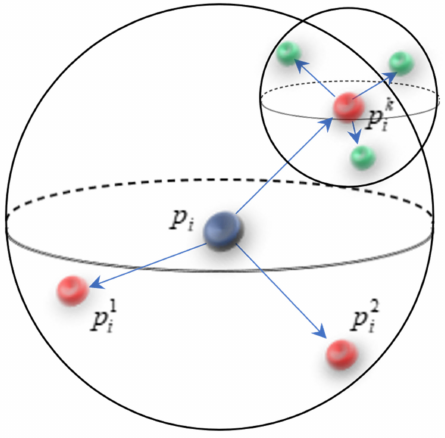
Figure 4. Two-step growth illustration in point cloud